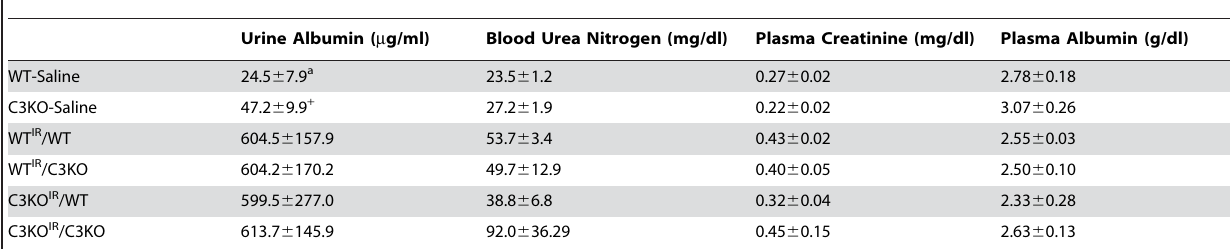
Table 1. Comparison of the degree of proteinuria and the status of renal function following induction of glomerulonephritis in chimeric mice versus saline injected